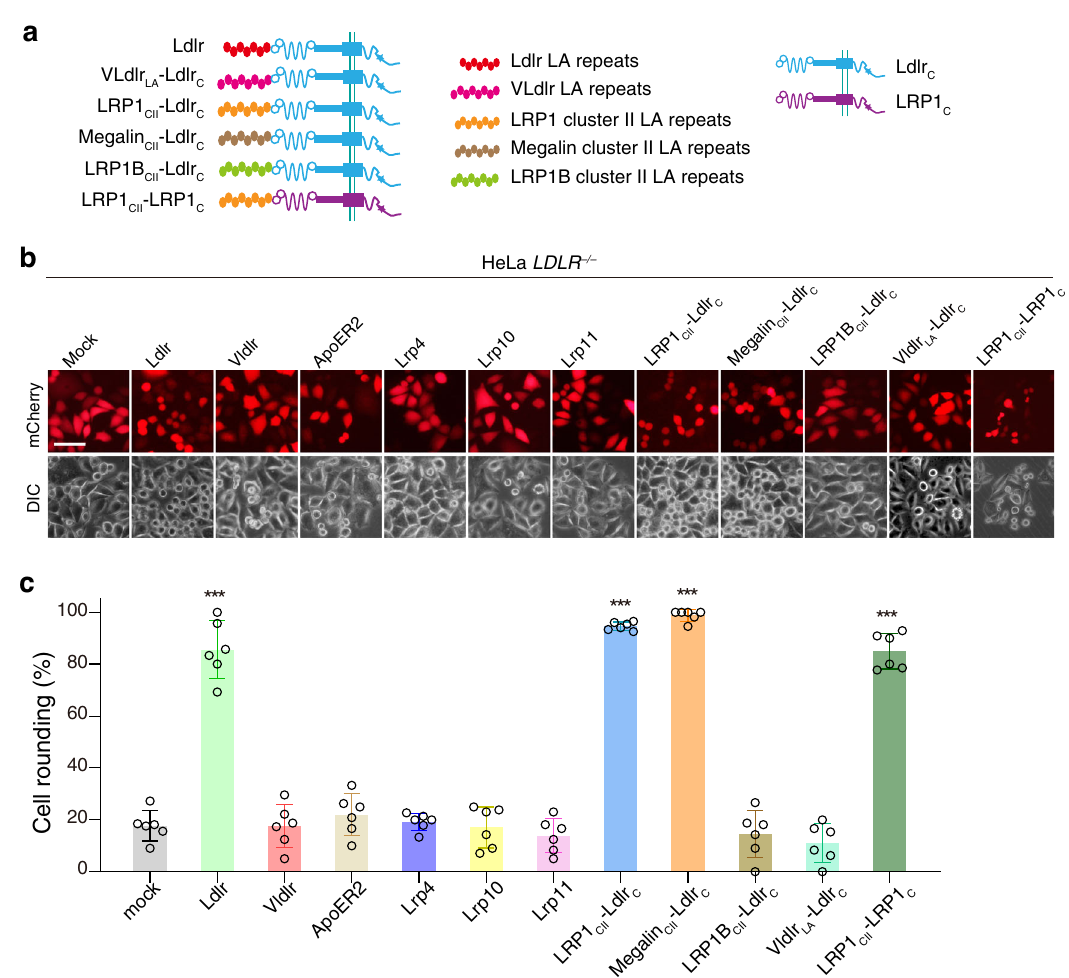
Fig. 2 LA domains of LRP1 and Megalin recognize Tcn α . a Schematic drawing of chimeric receptor proteins including VLdlr LA -Ldlr C , LRP1 CII -Ldlr C , Megalin CII -Ldlr C , LRP1B CII -Ldlr C , and LRP1 CII -LRP1 C . b The HeLa LDLR ‒ / ‒ were transfected with mock, Ldlr, Vldlr, ApoER2, Lrp4, Lrp10, Lrp11, LRP1 CII -Ldlr C , Megalin CII -Ldlr C , LRP1B CII -Ldlr C , VLdlr LA -Ldlr C , and LRP1 CII -LRP1 C , followed by the incubation with Tcn α (6 nM, 3 h). Red fl uorescence (mCherry) marked transfected cells. Representative images are shown. The scale bar represents 50 μ m. c The round-shaped cells among all mCherry-positive cells shown in b were quanti fi ed and plotted in a bar chart. Error bars ( n = 6) indicate mean ± SD, *** P < 0.001 versus mock, two-sided Student ’ s t